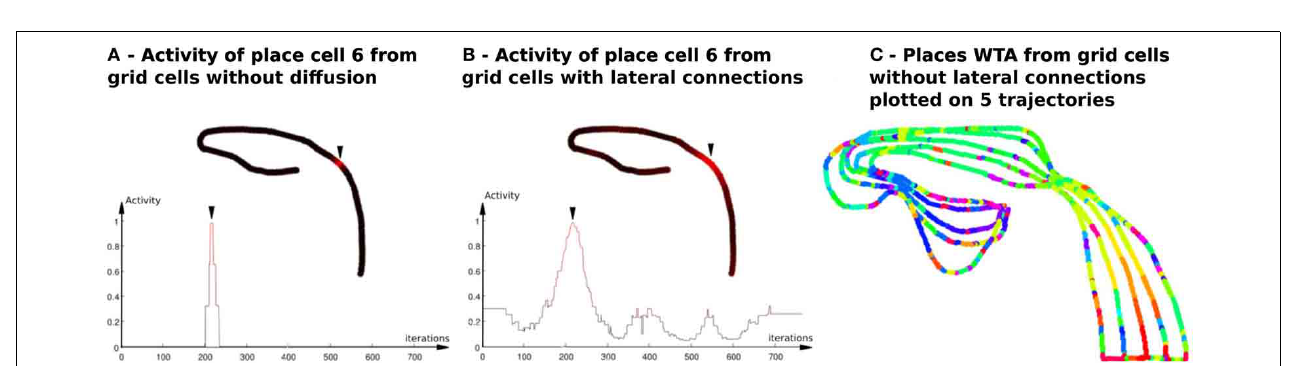
A red color means a high activity and a black one indicates a low activity. Location of the cell numbered 6 in the path is marked by an arrow. These connections allow to spread activity on neighboring grid cells. Bottom: Activity of the 6th PredVPC is recorded in time. On the x axis, iterations are proportional to the distance the robot has traveled (constant speed). PredVPCs show larger place fields allowing generalization capabilities. (C) Multiple place fields with PredVPCs from the binary grid cells (no diffusion). This figure shows the identity of the highest PredVPC (resulting from a Winner Takes All competition mechanism) superimposed to the path. At each time step a colored dot is plotted. Each color identifies the PredVPC with the highest response at the given place. It exhibits a lot of recognition errors (same color for different locations) that can be easily removed by adding the diffusion mechanism (see Figure 11